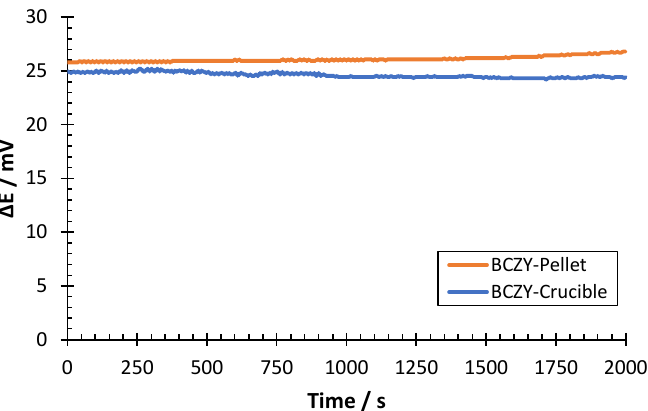
Figure 10. ∆ E measurement of a 0.2 mbar H 2 sample at 500 ◦ C for BCZY-Pellet and BCZY-Crucible